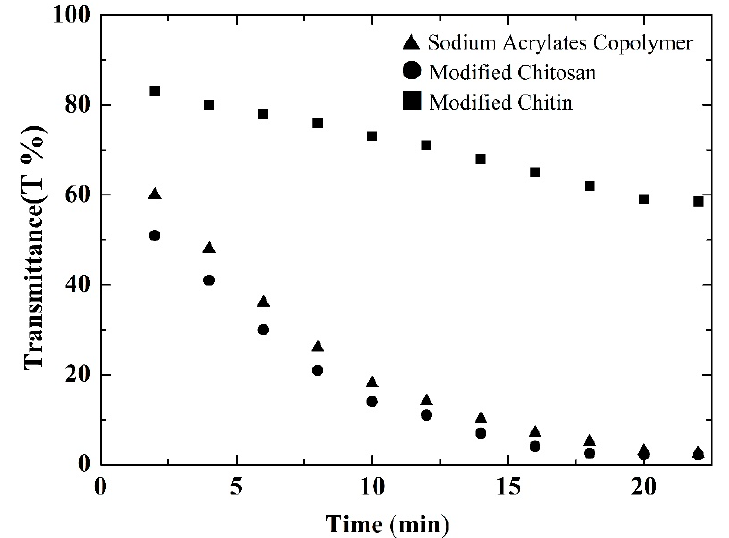
Figure 6. Change of transmittance with time.